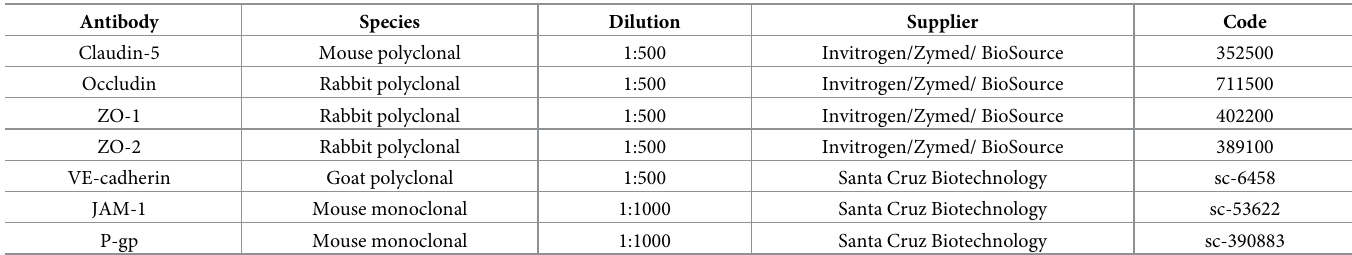
Table 1. Primary antibodies used in western blotting.